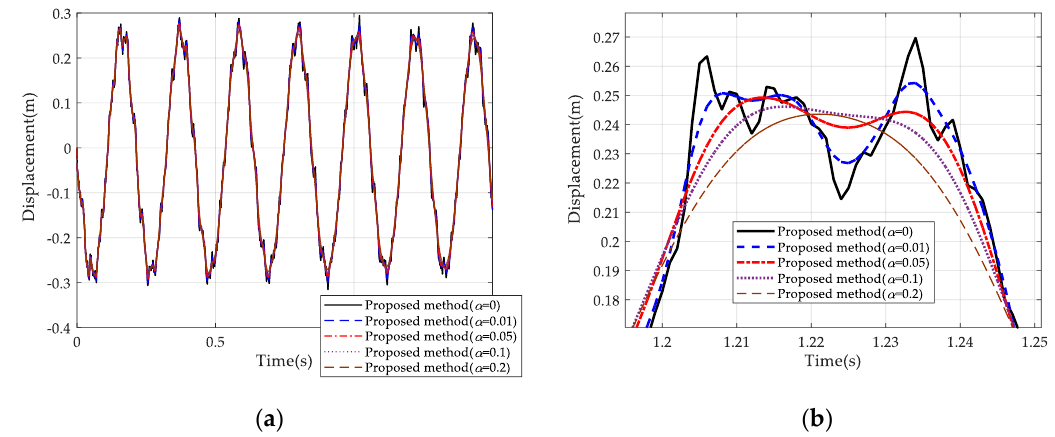
Figure 15. Vertical displacement responses of Point A with ∆ t = 0.001 s: ( a ) Displacement responses. ( b ) Partial enlarged drawing of displacement responses.